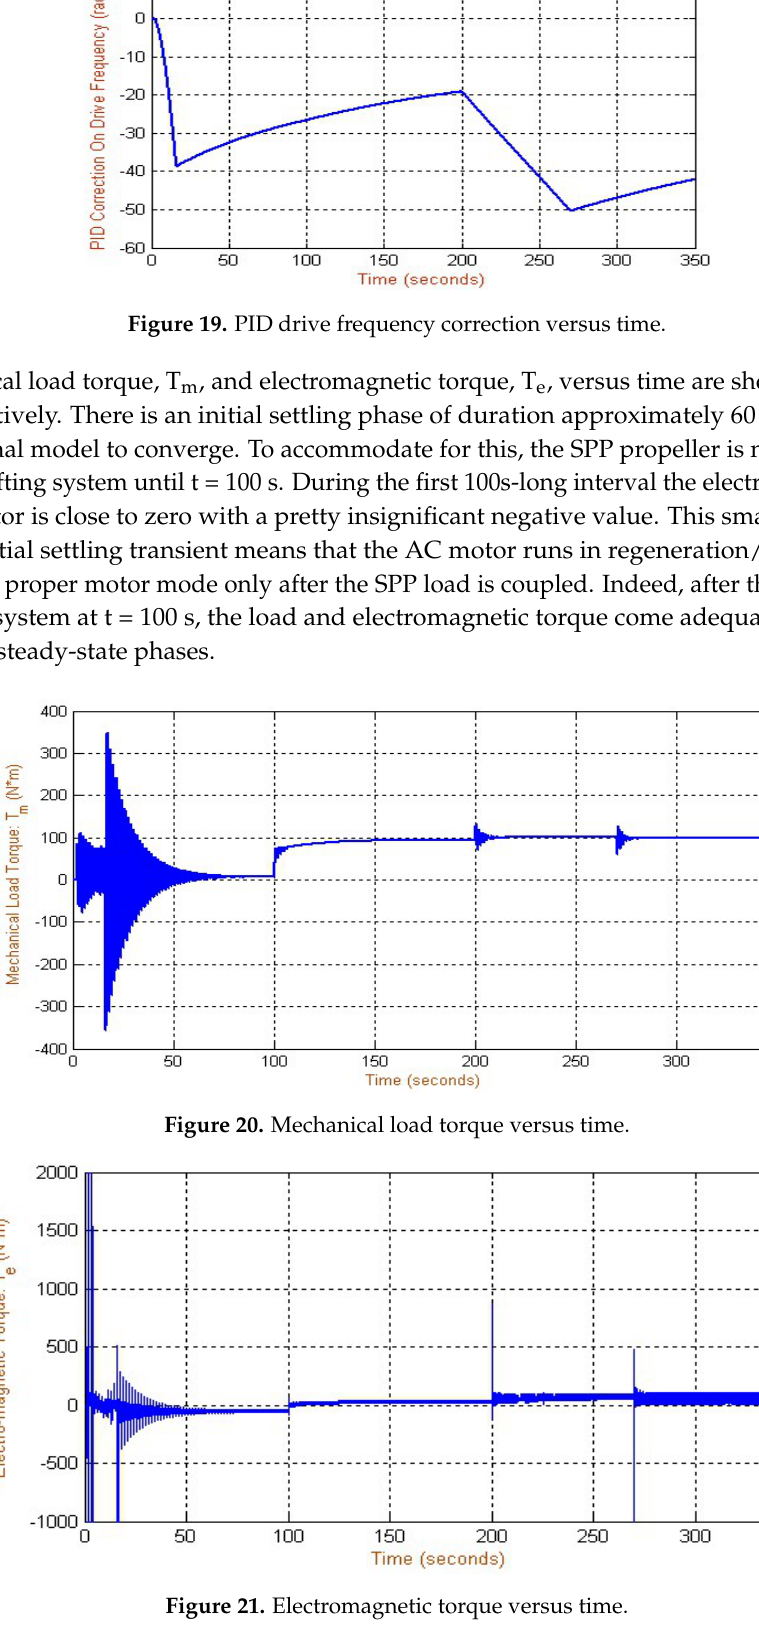
Figure 18. Rotor angular velocity versus time.